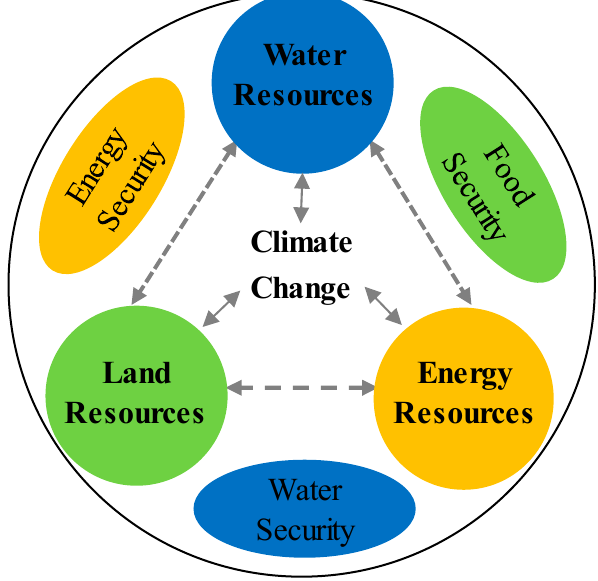
Figure 8. The Water–Food–Energy–Land–Climate Nexus.